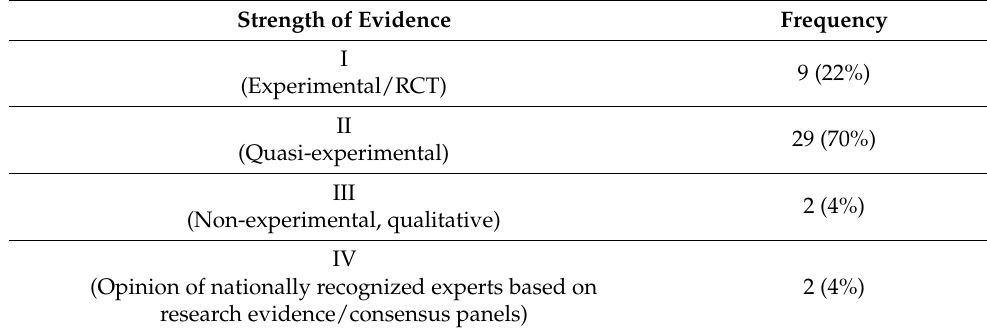
Table 3. Summary of quality